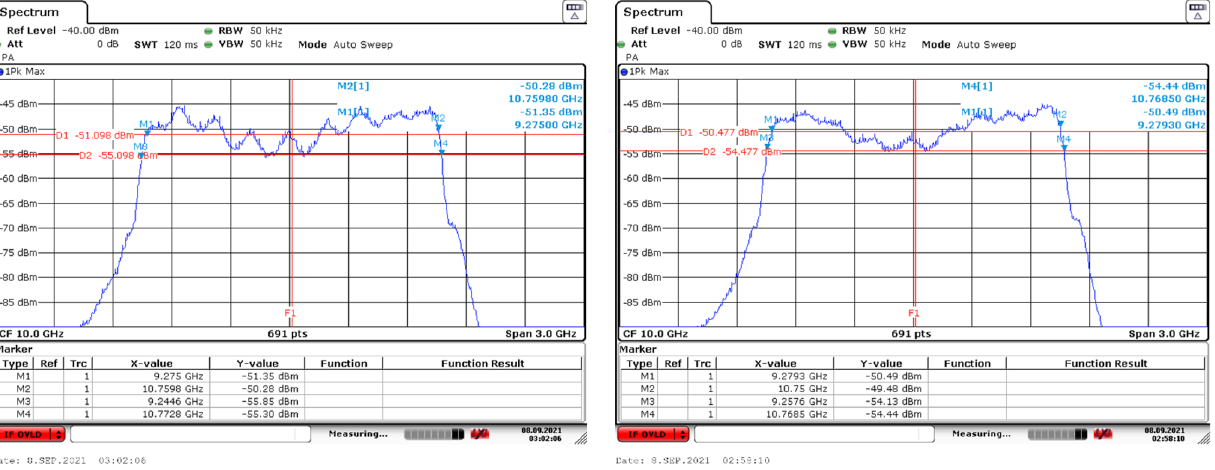
Figure 13. Configuration of the antenna and transceiver units. A noise generation/up converter (NGUC) generates noise and converts it into an RF band. Figure 14 shows the measured frequency spectrum of the generated and PRS noises. The bandwidth was more than 15%, and the flatness was within 4 dB for both cases.